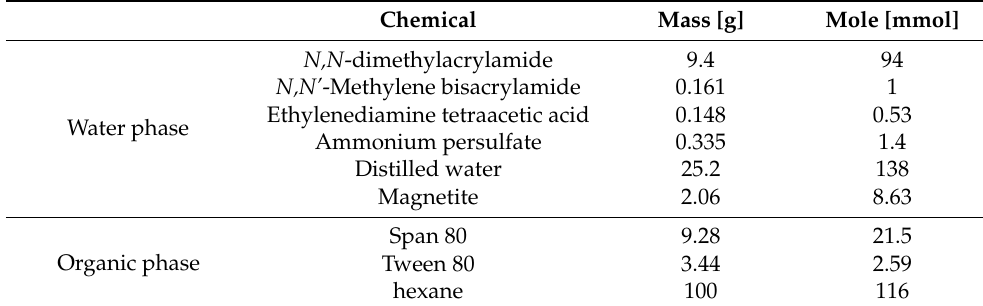
Table 1. Preparation condition of magnetite-containing